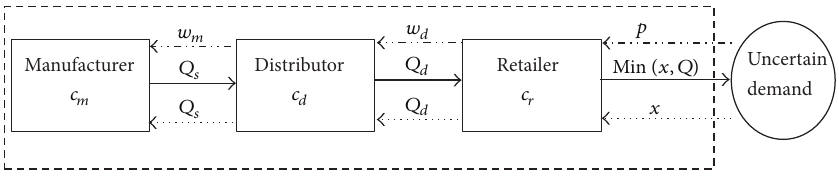
Figure 1: Three-level supply